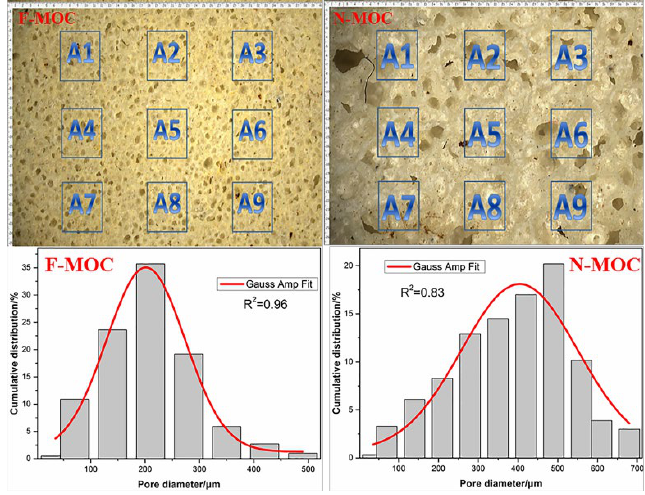
Figure 3. F-MOC and N-MOC aperture test interval diagram and aperture distribution digram(F-MOC bulk density was 540 kg·m −3 , N-MOC bulk density was 301 kg·m −3 ).